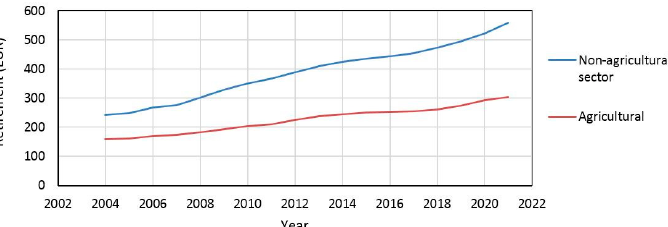
Figure 23. Mean monthly retirement in agricultural and non-agricultural sectors in Poland, 2004–2021, data obtained from [66].